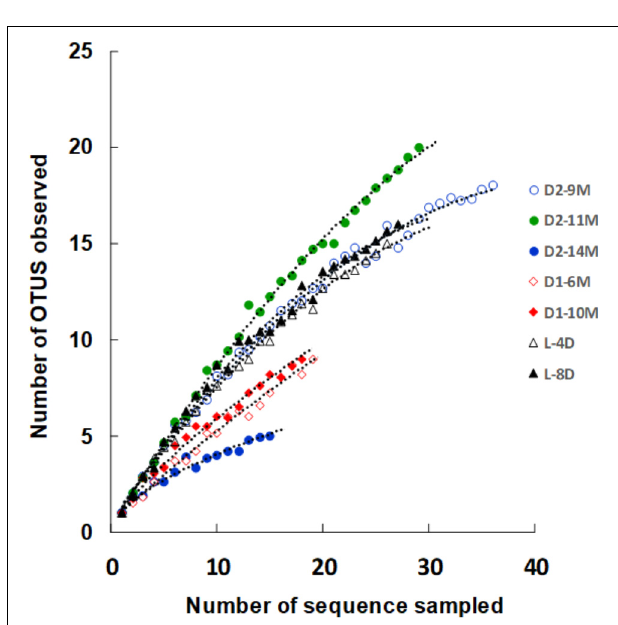
FIGURE 7 | Rarefaction curve of OTUs defined by 3% sequence variation in samples. The indigo fermentation fluids in the initial (L-4D and L8D) and aged phases (D1-6M, D1-10M, D2-9M, D2-11M, and D2-14M) were analyzed. The curve depicts the diversity of each sample. Sample names are the same as those in Figure 6 . OTUs, operational taxonomic units. This figure was reproduced from a figure in Okamoto et al. (2017). This reproduction was permitted by